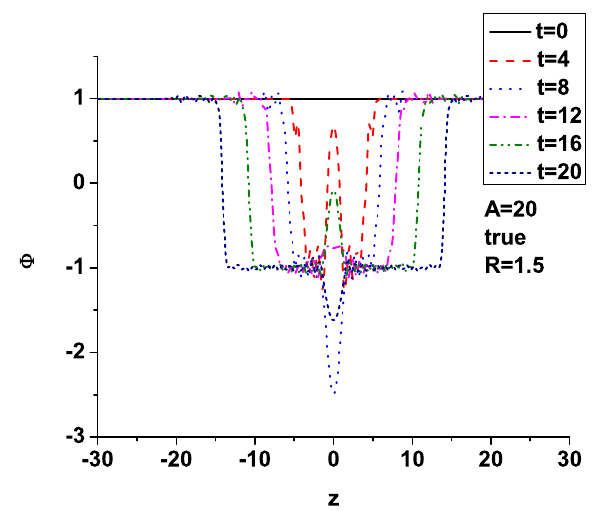
Figure 10 . A massive object triggering a false vacuum decay. We set initial v O = 0 , A = 20 , R = 1 . 5 , Λ = 1 , B = 1 , m = 10 10 , a = − 0 . 2 , r = 0 . The whole space was initially occupied by φ = Λ . The scalar field starts to evolve toward the lower values (true minimum) inside the